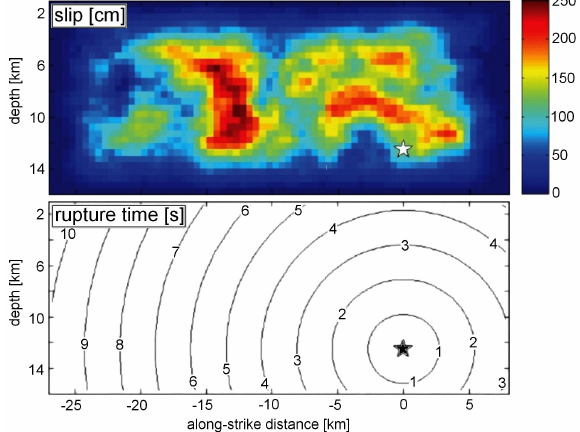
Fig. 6. Synthetic slip (top) and rupture time (bottom) distributions of the SPICE Tottori benchmark (Mai et al., 2007). Both the rupture speed and the rise time are constant at v r = 2 . 7kms − 1 and 0 . 8s, respectively.